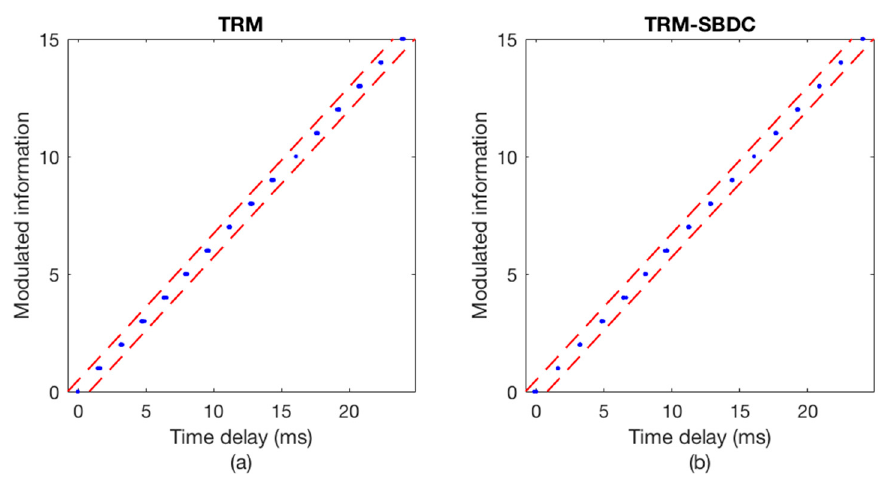
Figure 14. The decoding results when the sending boat is moored. ( a ) TRM; ( b ) TRM-SBDC.